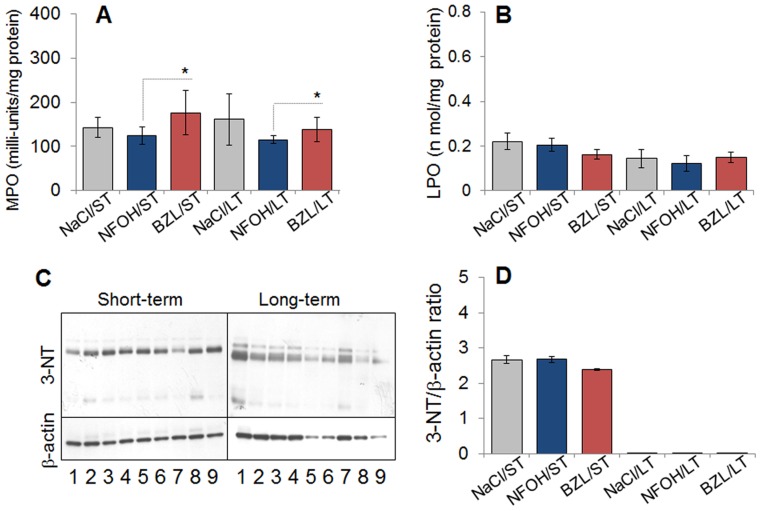
NFOH causes short-term phagocytic activation and oxidative damage.Mice were treated with NFOH and BZL as in Fig. 1, and liver tissue homogenates were prepared. (A) Myeloperoxidase activity was measured as a biomarker of phagocyte activation. (B) Lipid hydroperoxides levels were evaluated as a marker of oxidative stress. (C&D) Liver homogenates were subjected to Western blotting (C) with anti-3-nitrotyrosine antibody (Control: anti-β-actin antibody). Densitometry quantitation of 3-NT band intensity, normalized to β-actin, is presented in panel D.